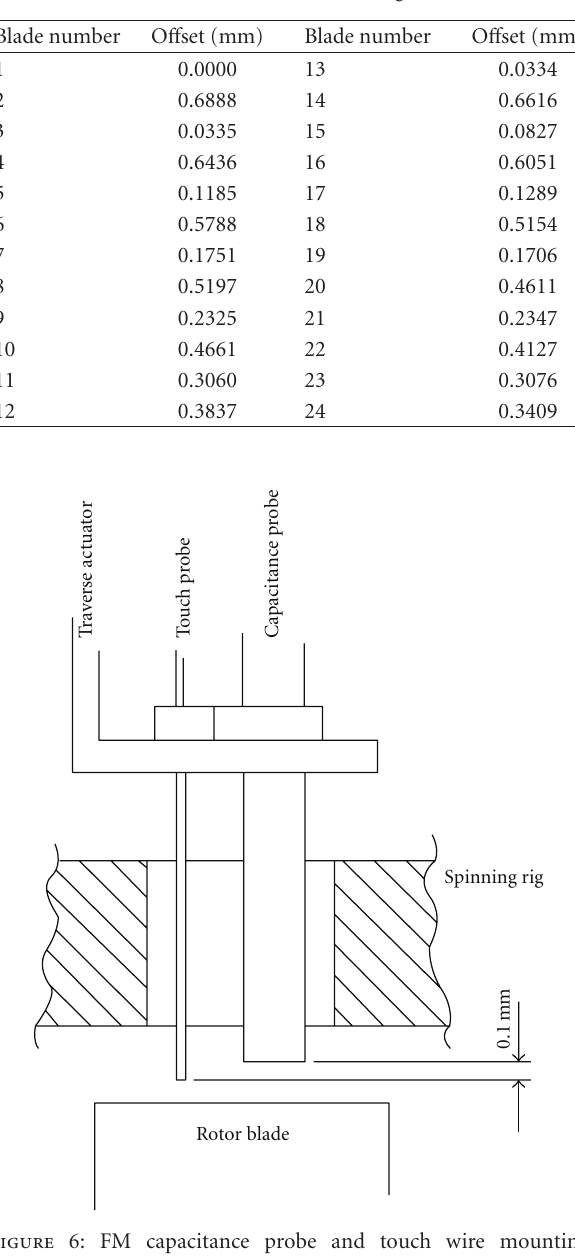
Table 2: Blade o ff set from the longest blade.